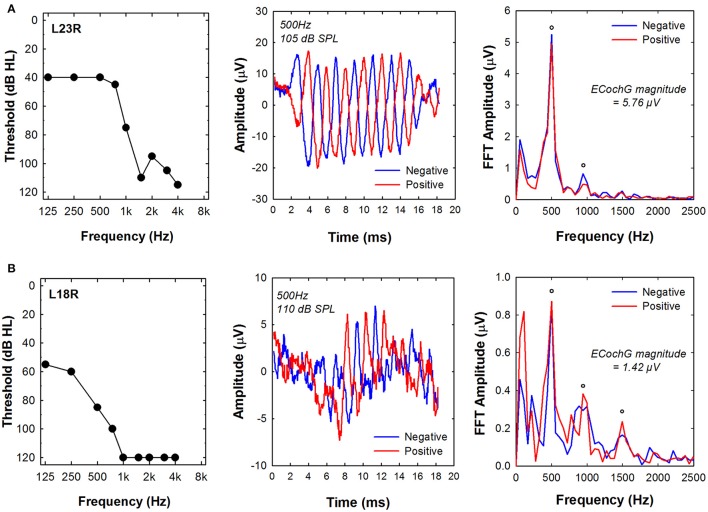
Examples of ECochG responses recorded using a 500 Hz tone burst from two subjects, (A) L23R and (B) L18R. Left panels show the audiogram measured at the time of testing. Center panels show the time waveforms in response to positive and negative leading tone bursts. Right panels show the results of a FFT of the time waveforms. The circles indicate frequencies where the energy at the harmonic frequency was significantly above the noise floor of the measurement system. Note the different amplitude scales used for these two subjects. ECochG indicates electrocochleography; FFT, Fast Fourier Transform.